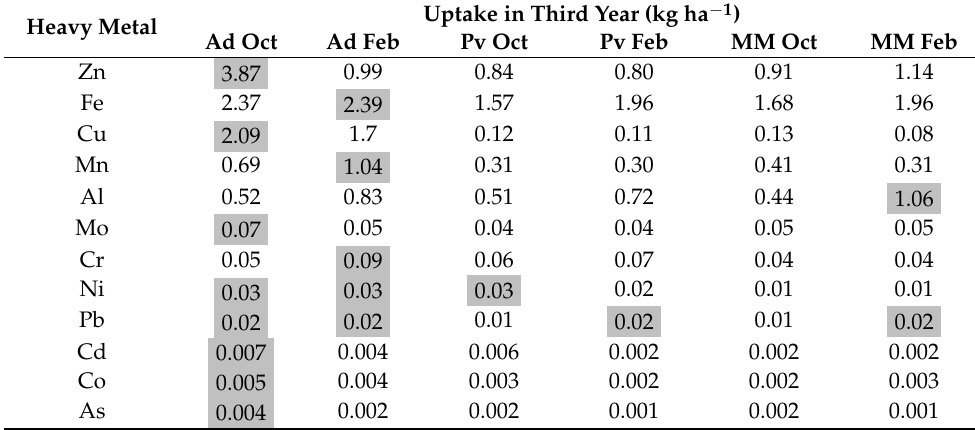
Table 3. Heavy metal uptake in the Caffaro area considering the yield from the third year of the experiment. Values are listed for A. donax L. (Ad), switchgrass (Pv) and mixed meadows (MM), for October (Oct) and February (Feb) harvests. Higher values are shown on a gray background. Heavy Metal Ad Oct Ad